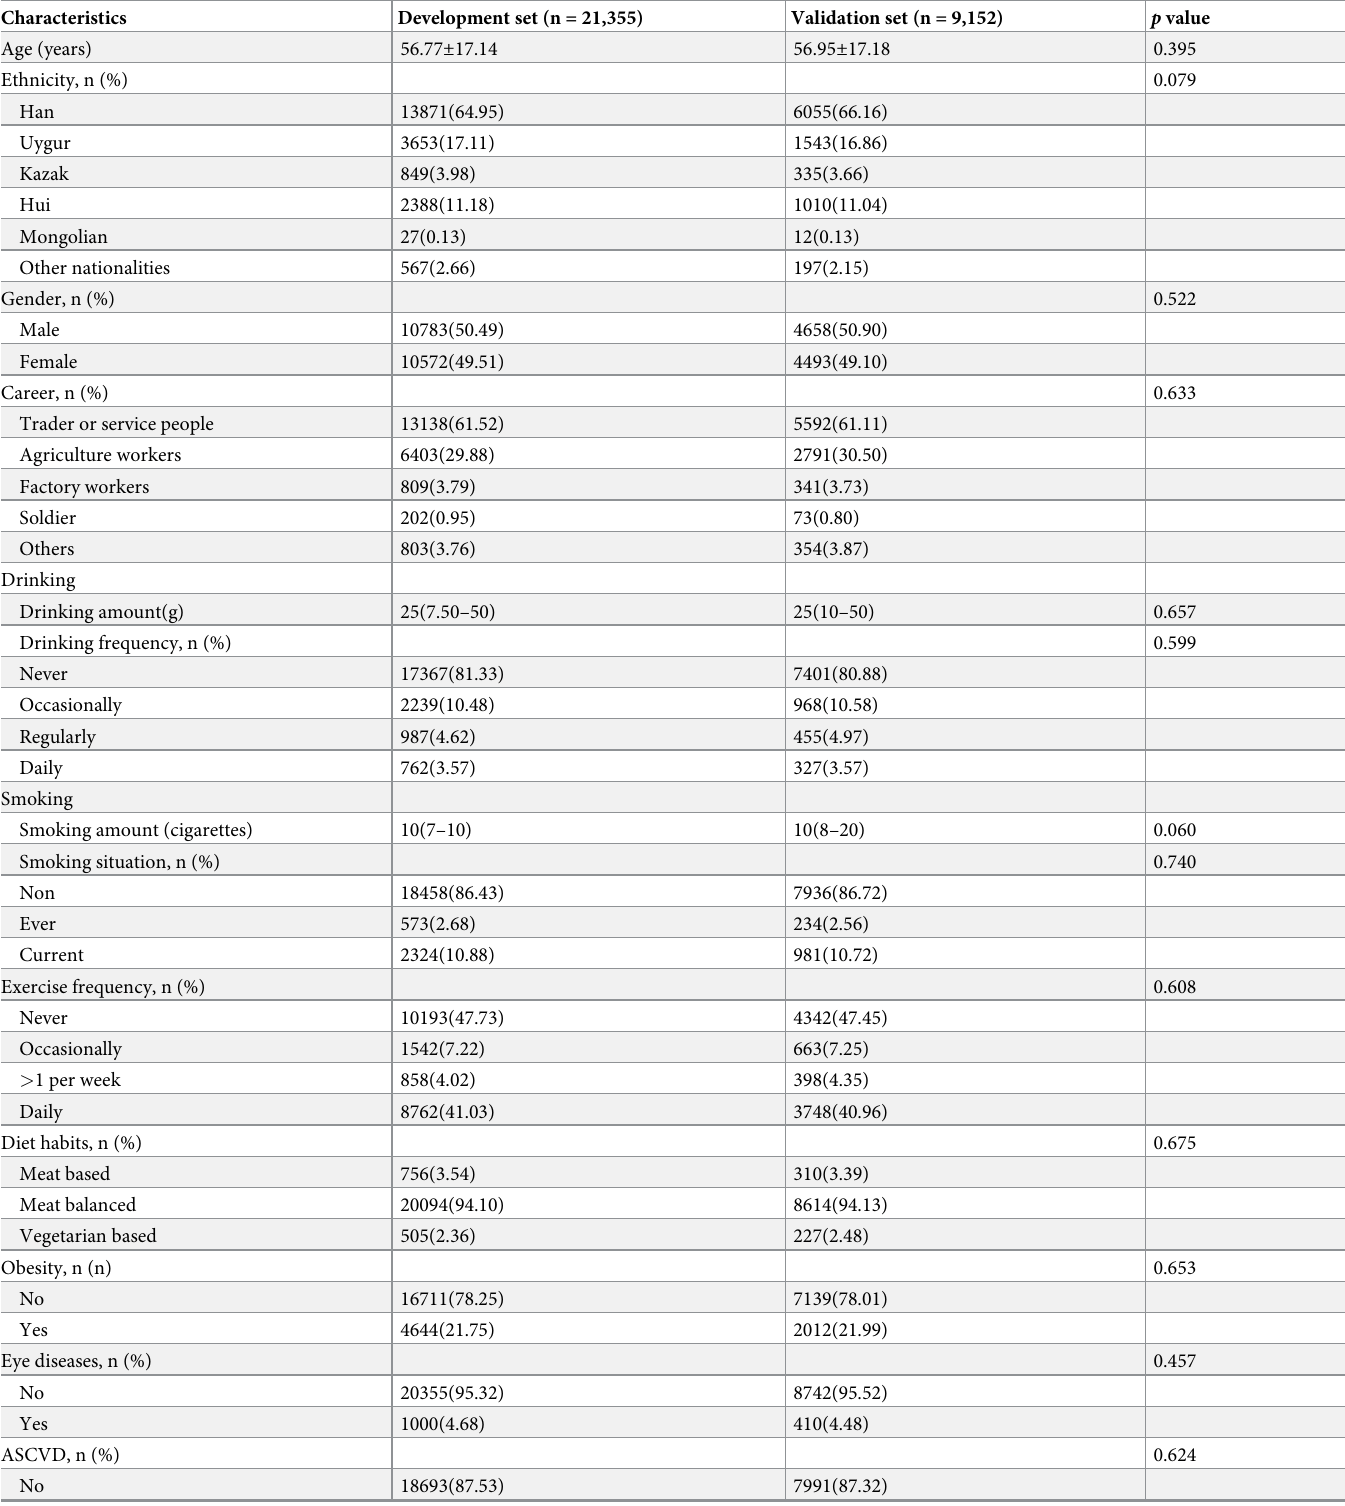
Table 1. Characteristics of the development set and validation set (n =